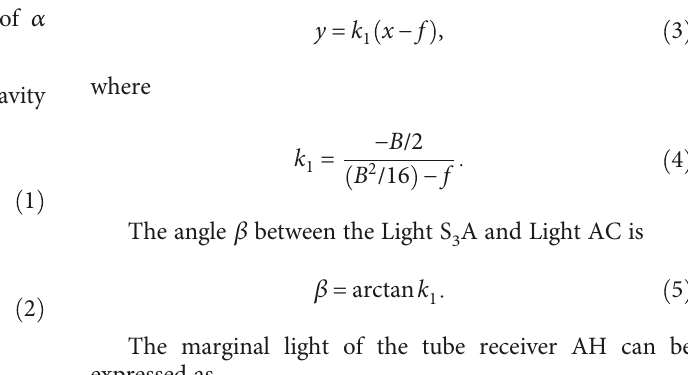
=12 mm and α =0.2 ° ; and (f) L el